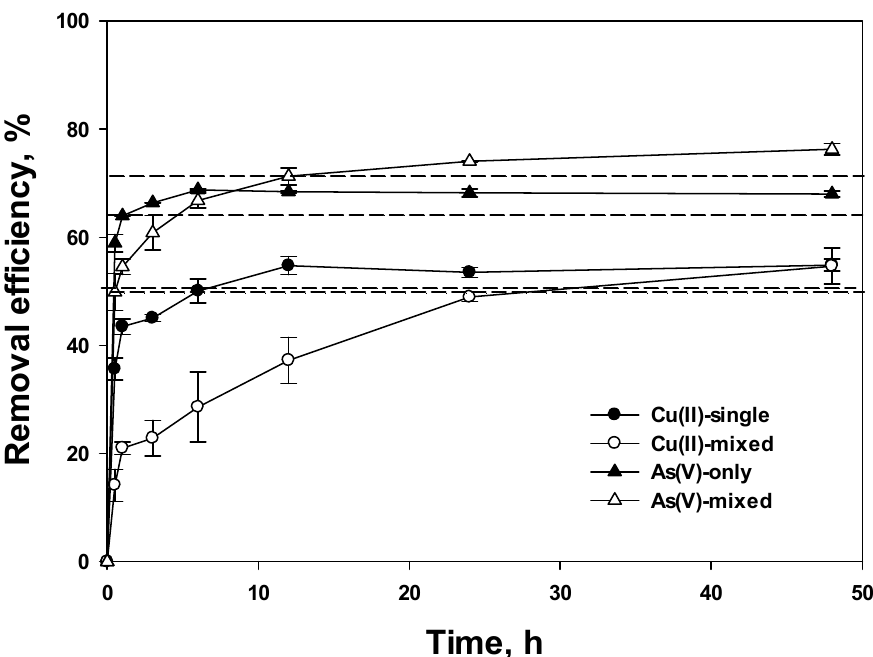
Figure 3. Removal e ffi ciency (%) of Cu(II) and As(V) in the presence of single and / or mixed solutions Figure 3. Removal efficiency (%) of Cu(II) and As(V) in the presence of single and/or mixed solutions (dash lines indicate 90% removal e ffi ciency (%), and the dotted line for Cu(II)-single and Cu(II)-mixed (dash lines indicate 90% removal efficiency (%), and the dotted line for Cu(II)-single and Cu(II)-mixed were very were very close).